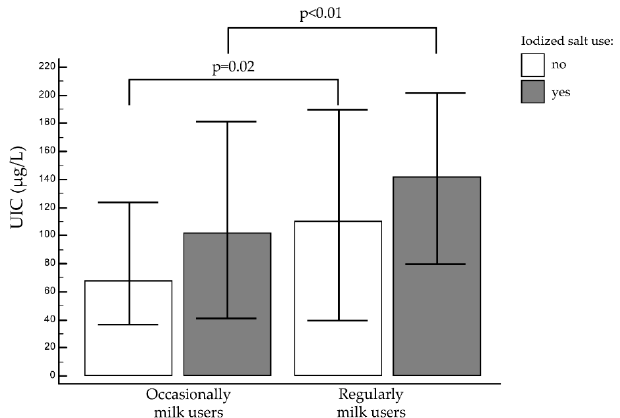
Figure 2. Median urinary iodine concentration (UIC) and milk intake in iodized salt users (grey bars) and non-users (white bars). Bars represent UIC median values ( µ g / L), while error bars represent interquartile range interval of the median value; milk: occasionally = less than once a day, regularly = daily or